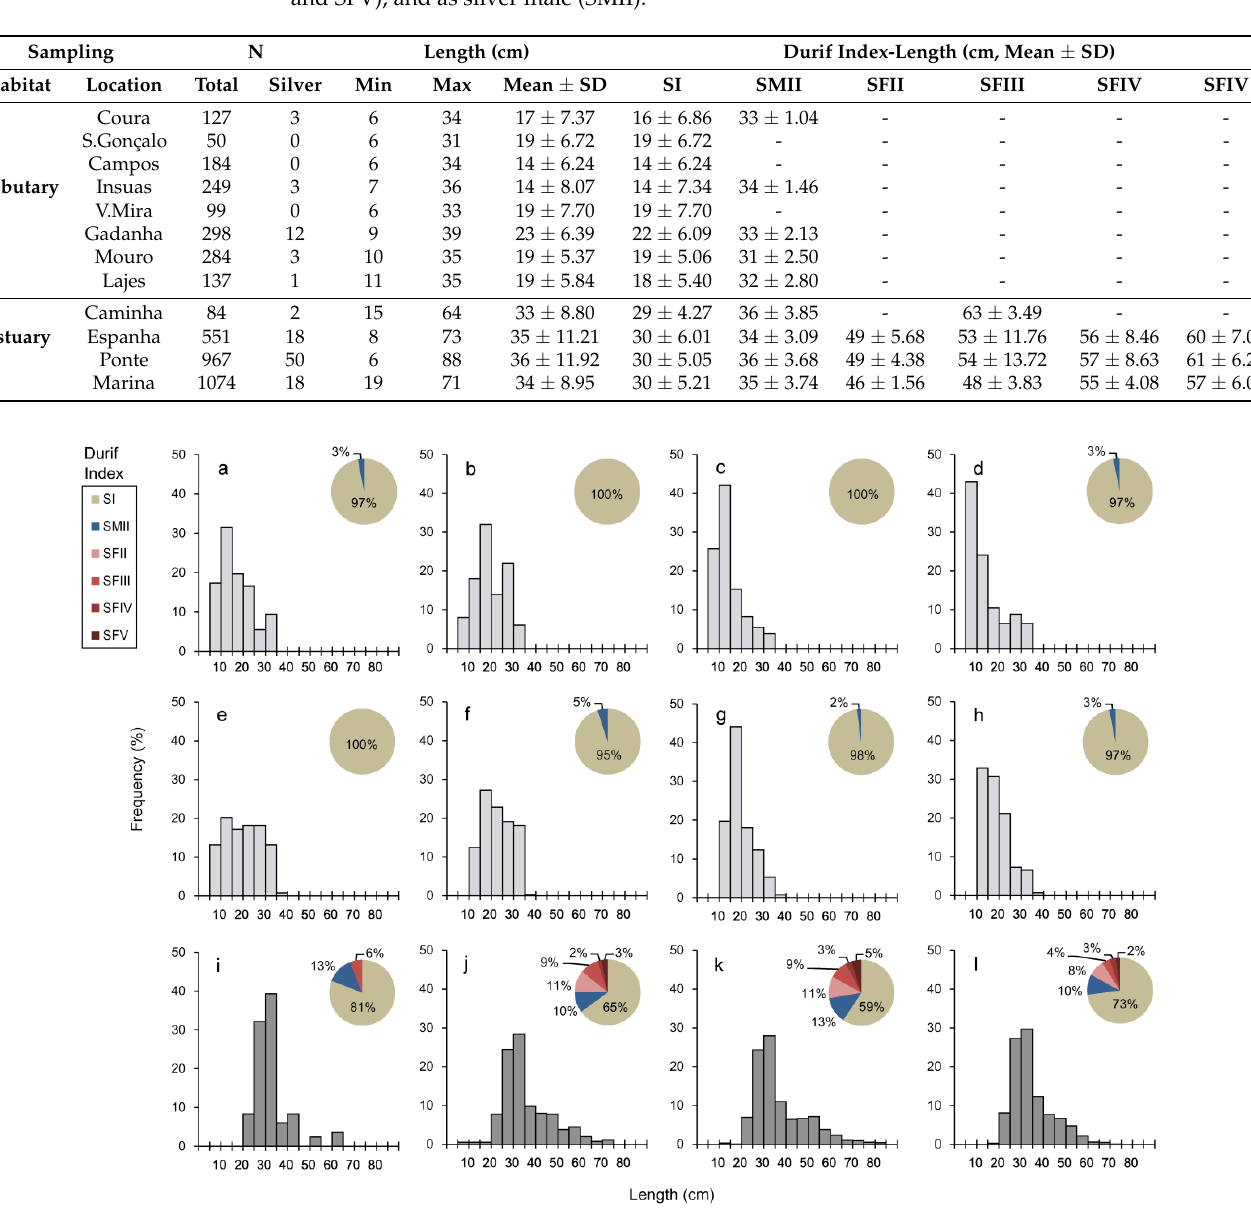
were yellow-stage eels, 14.5% of which were females, and the rest were classified as silver eels (4.5% females and 11.5% males). The number of females and silver eels in the estuary slightly increased with increasing distance from the river mouth (Figure 3). Table 1. Eels caught in the monitoring campaigns in the Minho River between November 2017 and October 2020. Data presented include: total sample size (N total), the number of silver eels classified macroscopically (N silver), minimum, maximum, and mean (±standard deviation, SD), total length (cm) of all eels, and the mean (cm ± SD) total length (cm) of the individuals characterized using the Durif Silvering Index as yellow resident (SI and SFII), female pre-migrant (SFIII), silver female (SFIV and SFV), and as silver male (SMII). N Length (cm) Durif Index-Length (cm, Mean ± SD)